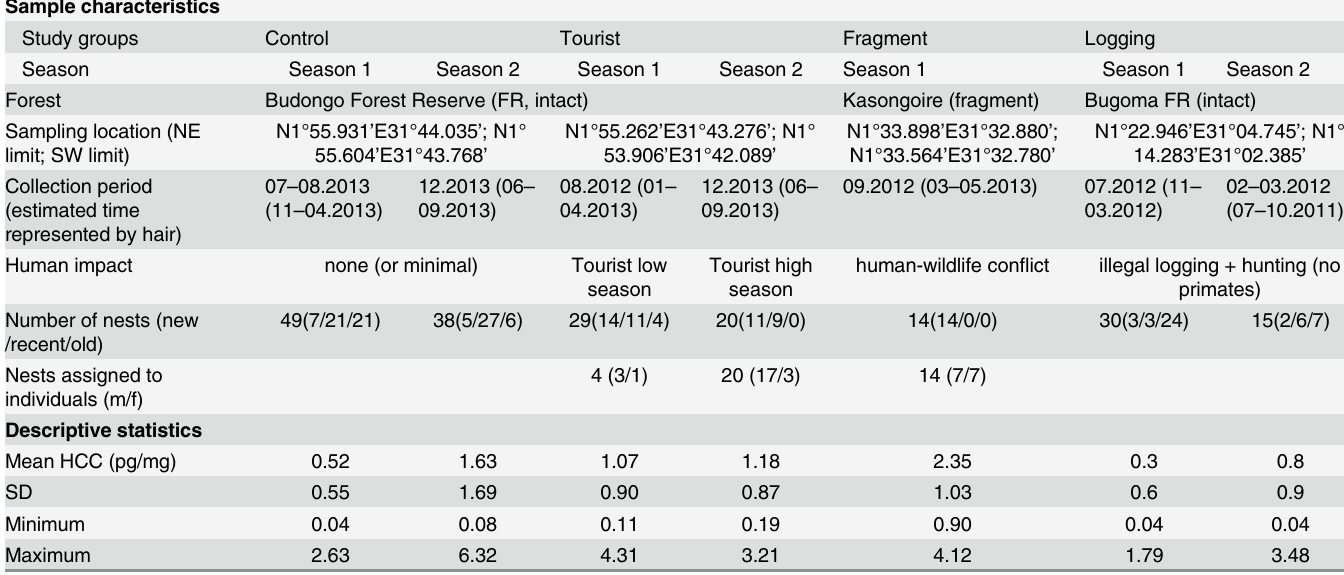
Table 1. Sample characteristics and descriptive statistics for hair cortisol concentrations of hair samples collected from chimpanzee sleeping nests in